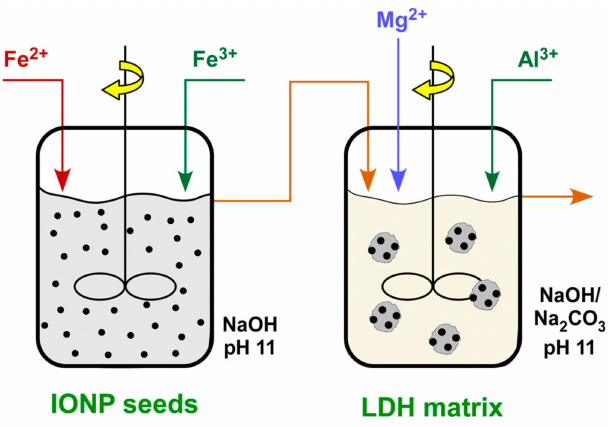
Figure 2. Continuous-flow reactor sequence for the production of the Fe 3 O 4 /Mg-Al LDH